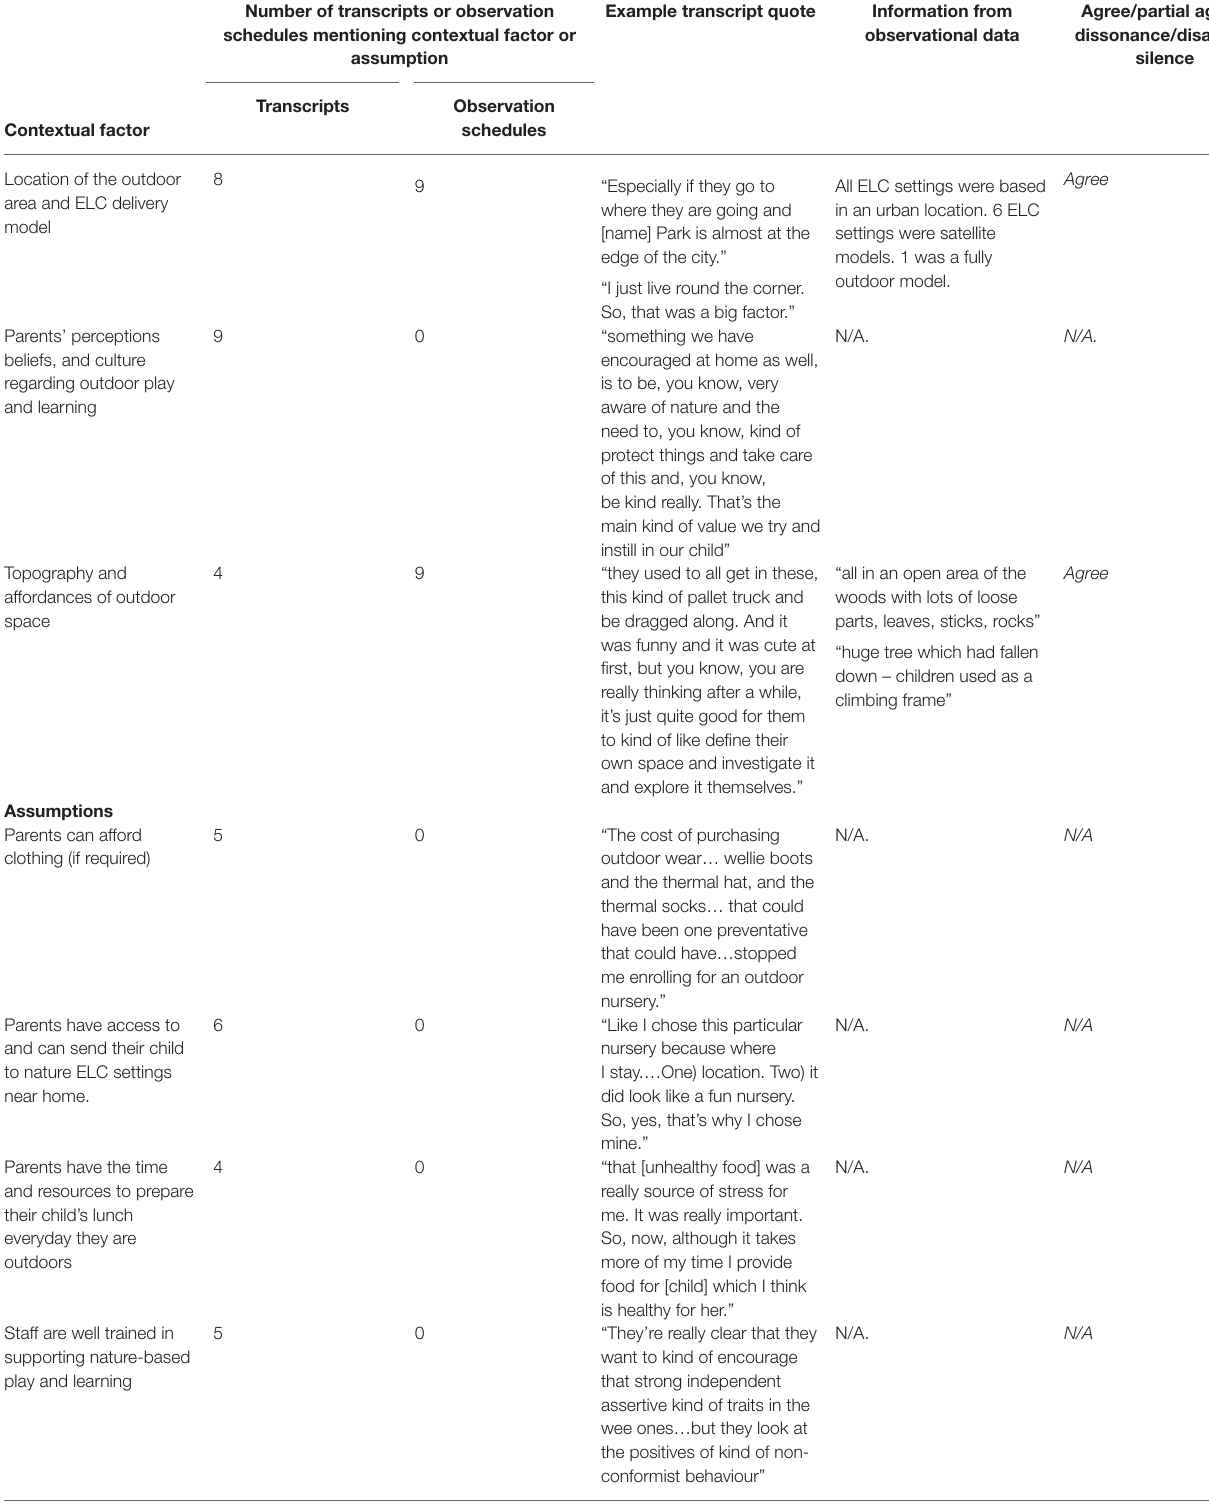
TABLE 4 | Triangulation of contextual factors and underlying assumptions from analysis transcript and observation